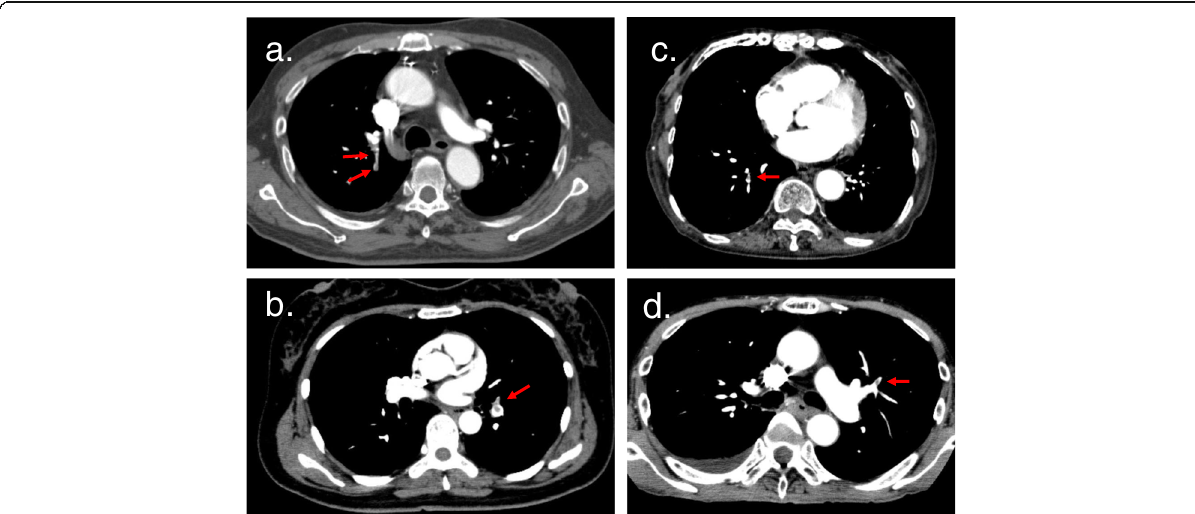
Fig. 2 Enhanced CT images of pulmonary embolism in four patients with acute appendicitis. Red arrows indicate thrombi. a On POD3, plasma D-dimer level was elevated to 23.3 μ g/ml. Enhanced CT revealed thrombus in right pulmonary artery. DVT was not found. b On POD6, the patient complained of right lower leg pain. Enhanced CT was performed without D-dimer test. Embolism in the left pulmonary artery and thrombi in the right popliteal vein and the right soleal vein were detected. c On POD6, plasma D-dimer level was elevated to 48.0 μ g/ml. Some embolus was detected on both sides of the peripheral pulmonary arteries. DVT was detected in the left soleal vein. d On POD5, plasma D-dimer level was elevated to 33.2 μ g/ml. Pulmonary embolism was detected in the upper right pulmonary artery. DVT was detected in the right popliteal vein. CT, computed tomography; POD, postoperative day; DVT, deep venous thrombosis